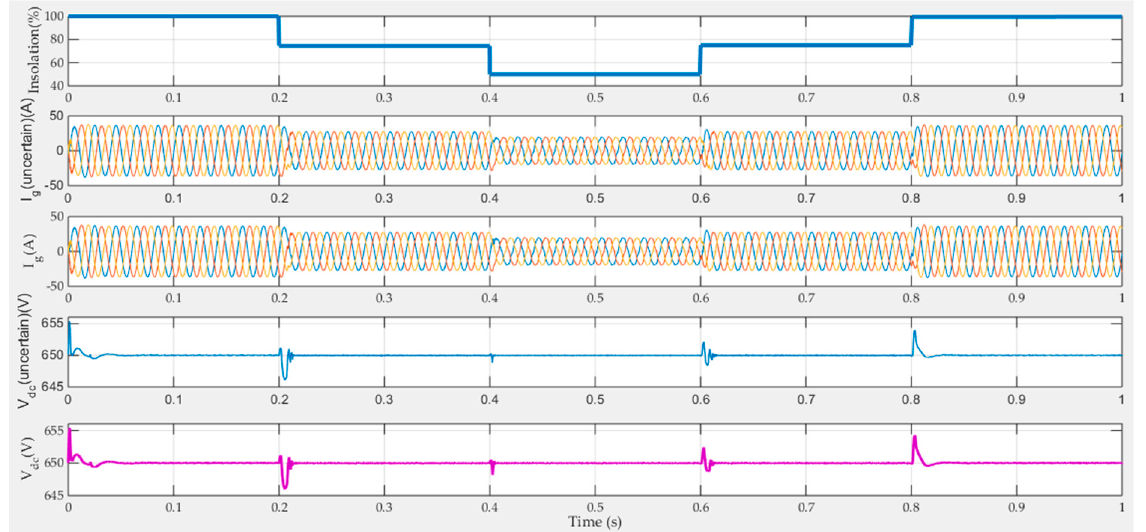
Figure 12. The response of the proposed system under parameters uncertainty, @ weak grid.